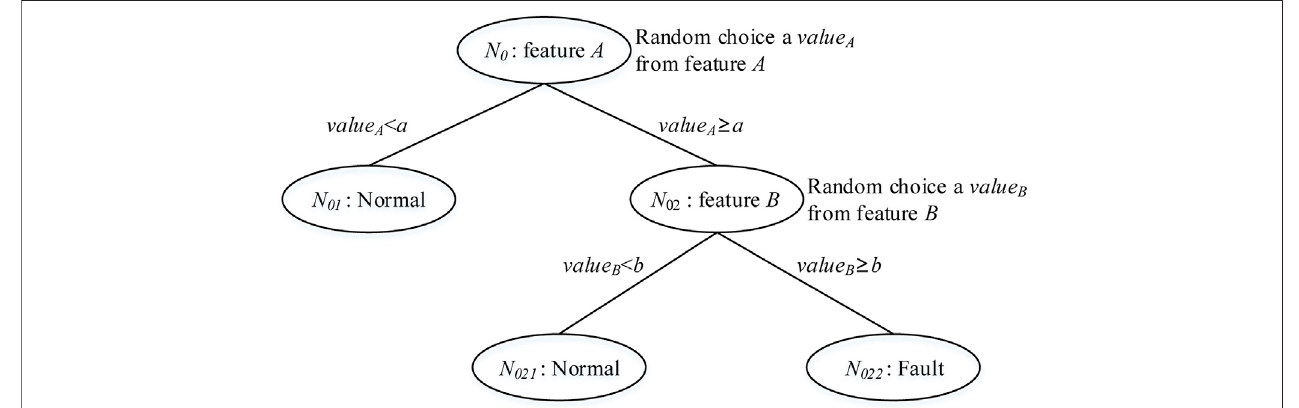
FIGURE 1 | Split rule of CS-ERT algorithm.